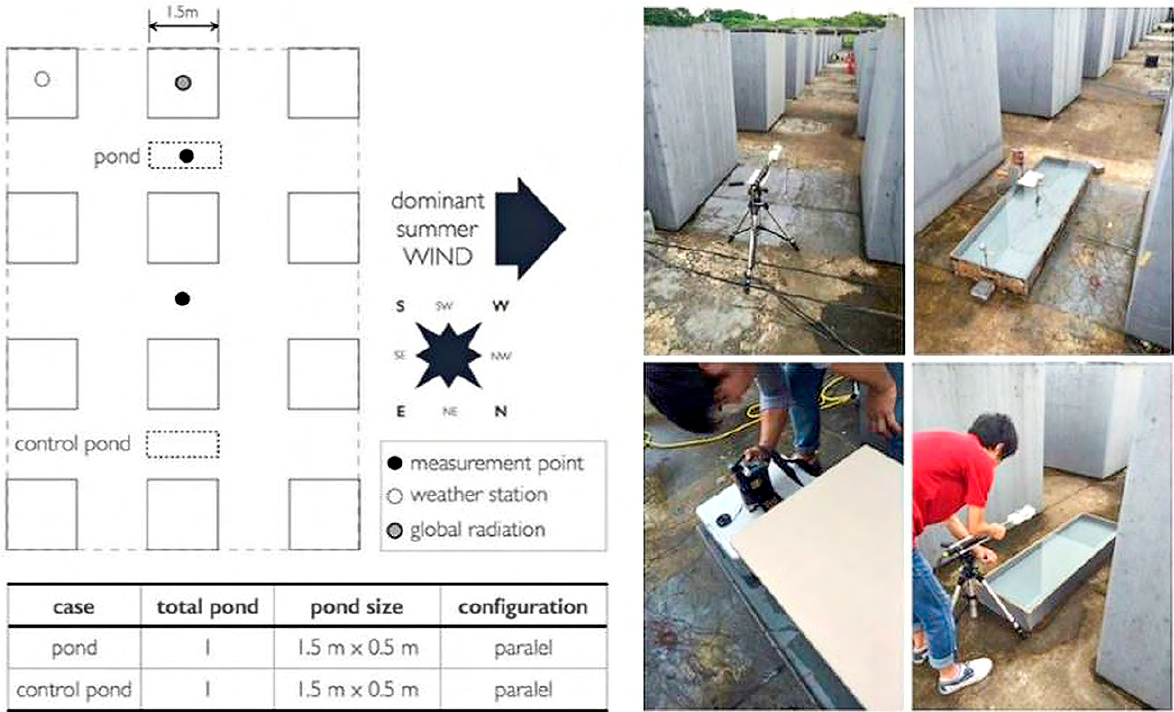
Figure 2. Experimental studies arrangement on the radiation exchange